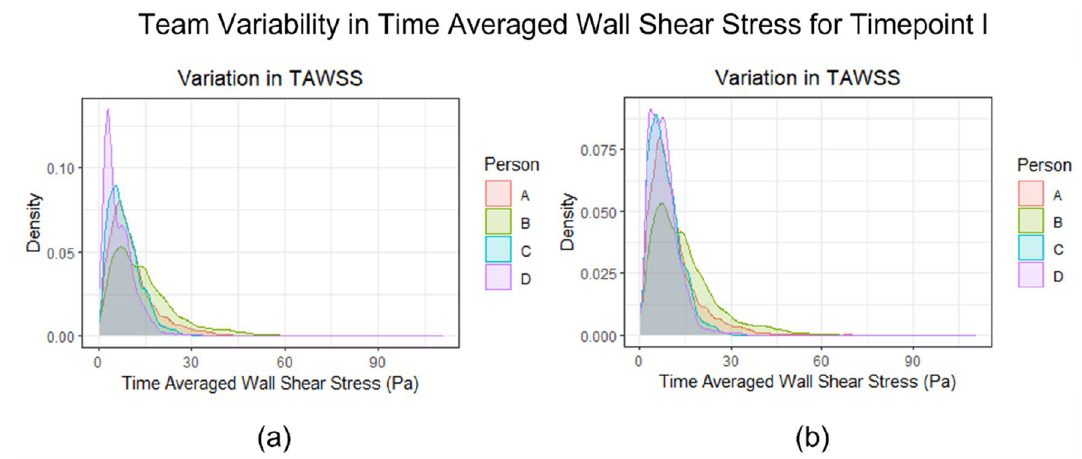
Figure 4. Comparison of the density distribution plots representing the operator variability in the TaWSS parameters for time point I. ( a ) Geometries with differences in the length of inlet and outflow branches as reconstructed by different operators; ( b ) post-processed geometries considering the region of interest (aneurysmatic region and attached arteries) for all